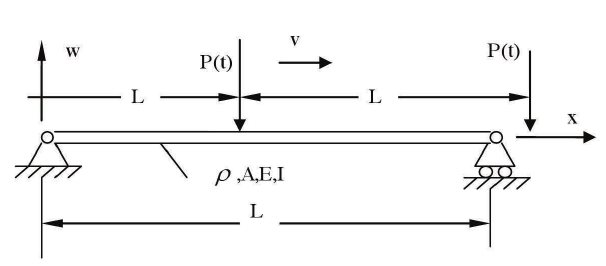
Figure 1. Bridge model with moving